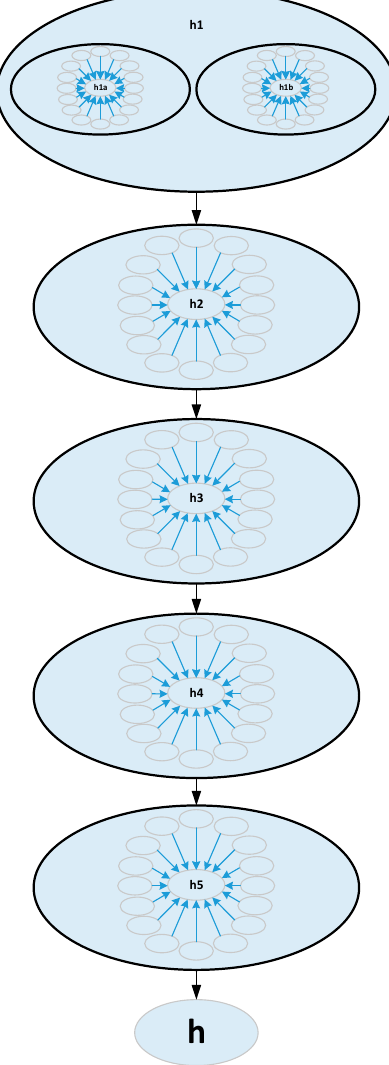
Figure 7. General model of information quality for weather stations.